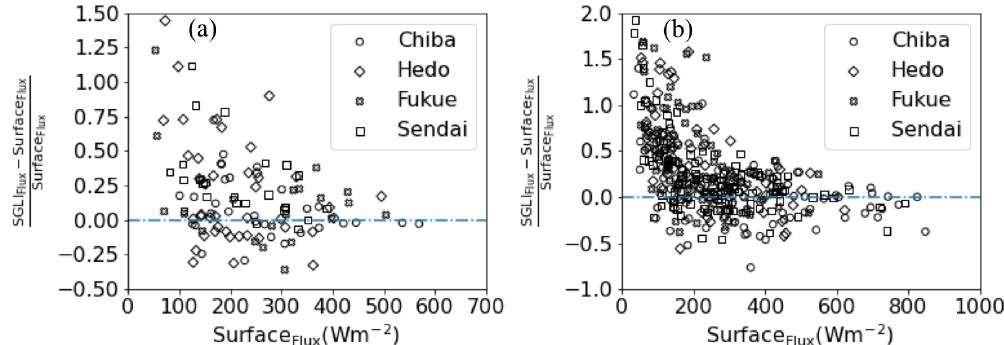
Figure 12. Scatter plots for modeled and observed global irradiance difference and observed global irradiance for (a) water clouds and (b) ice